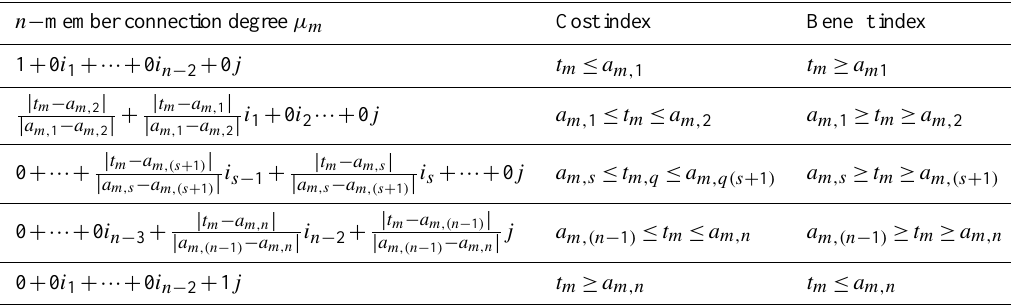
Table 1. The formula of n -member connection degree I m of index layer.